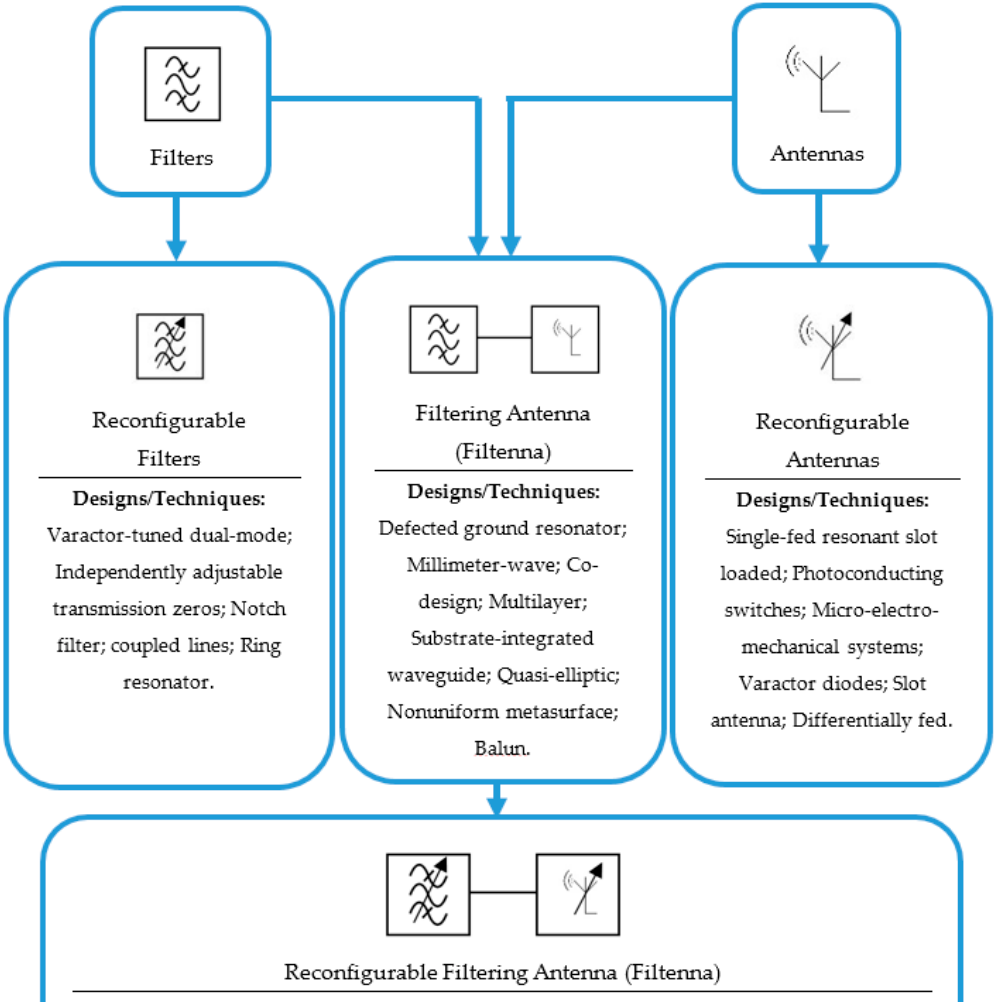
Figure 1. Graphical summary of the surveyed designs [28–86].